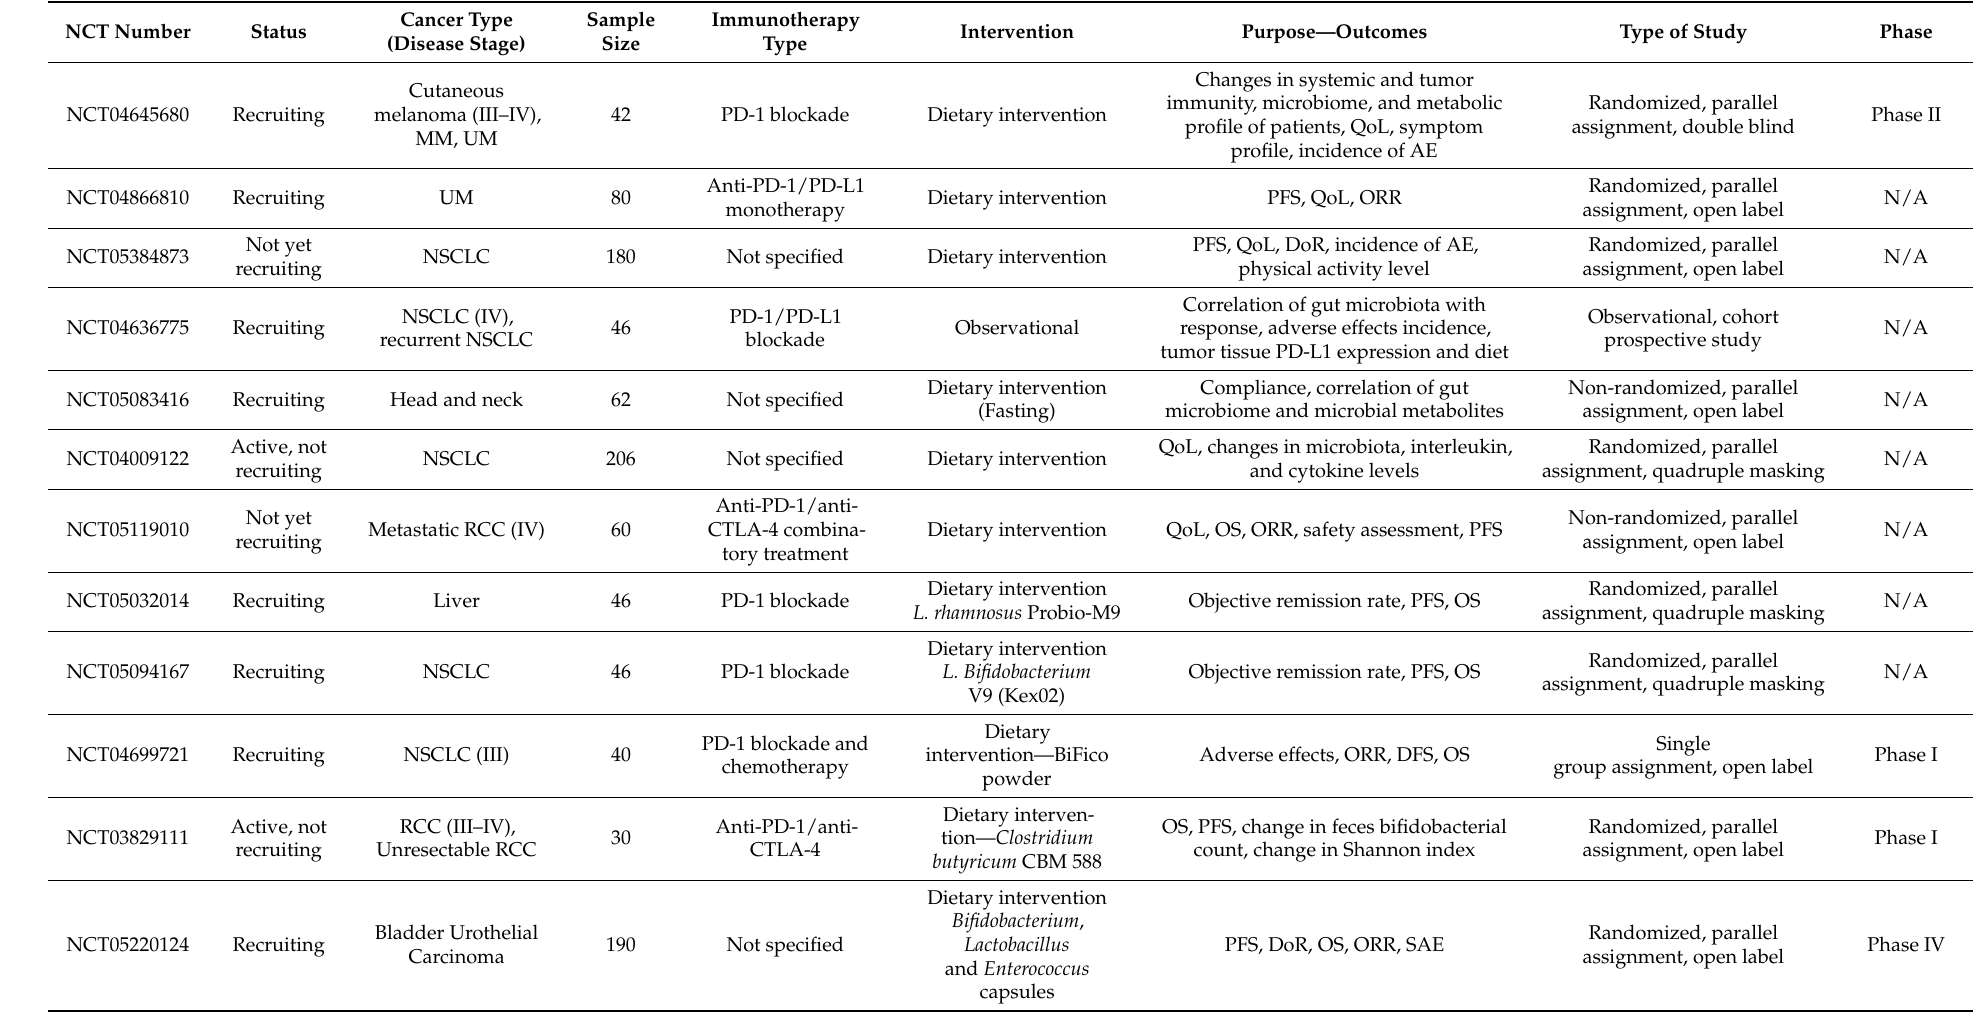
Table 3. Ongoing interventional clinical trials on intestinal microbiota and anti-tumor